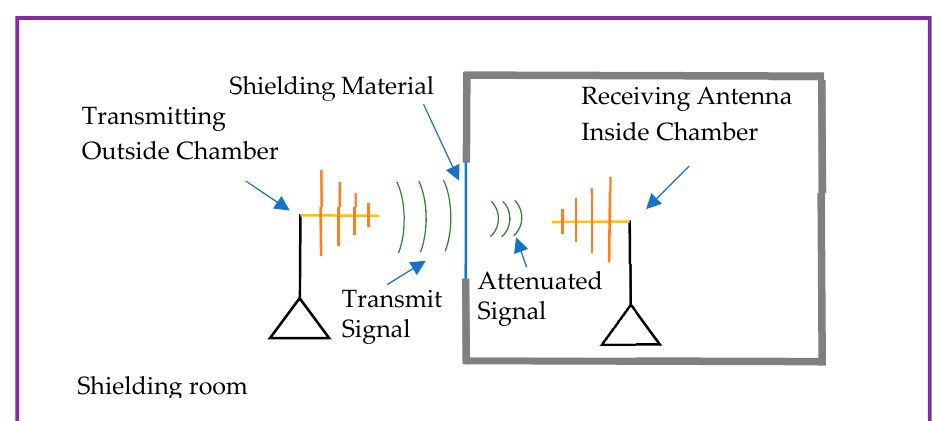
Figure 3. Source and receiver of the network analyzer.